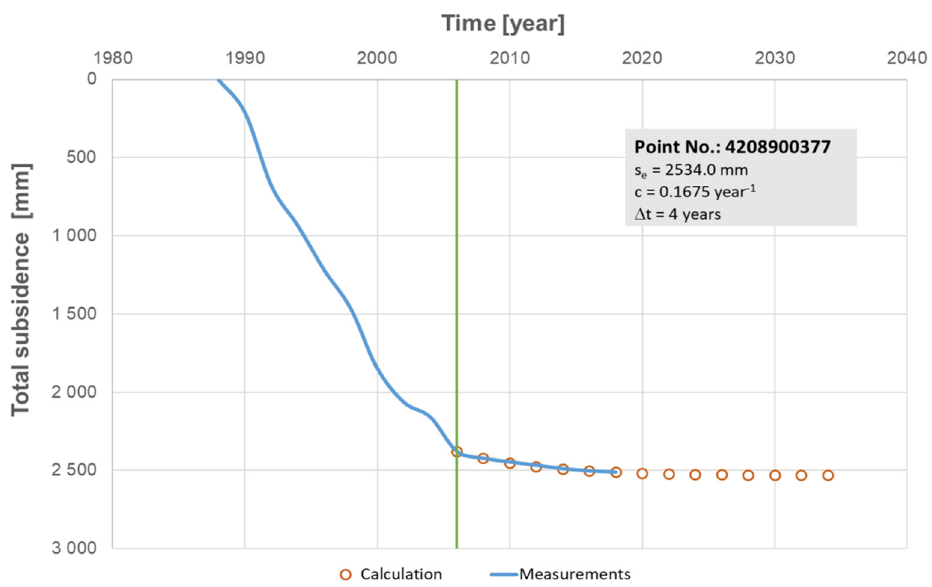
Figure 7. Diagram of the forecasted course of subsidence for point 4208900377 after the end of exploitation (2006). Table 6. Estimated time of subsidence for subsidence limit values.